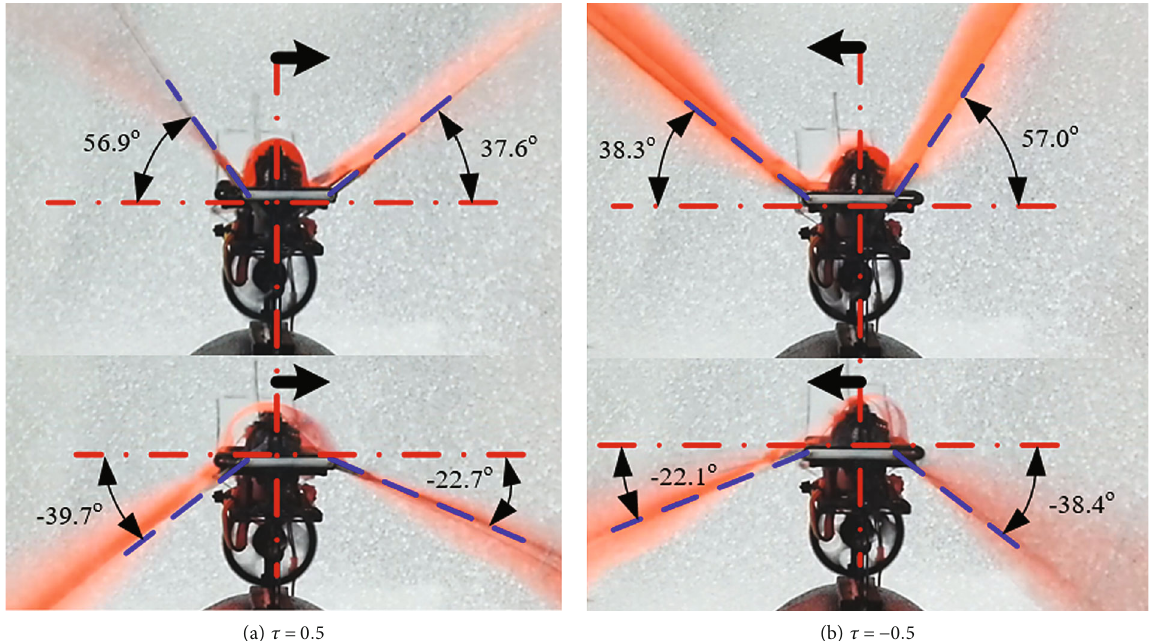
Figure 9: Maximum and minimum fl apping angles at τ = ±0 : 5